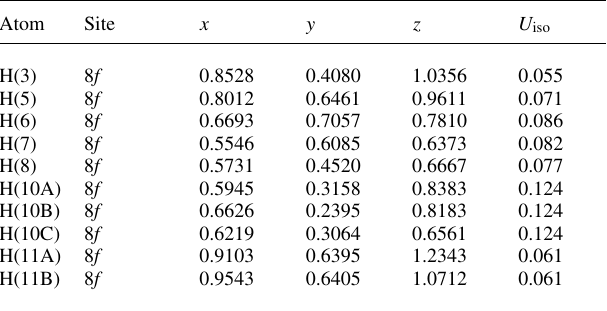
Table 2. Atomic coordinates and displacement parameters (in Å 2 )